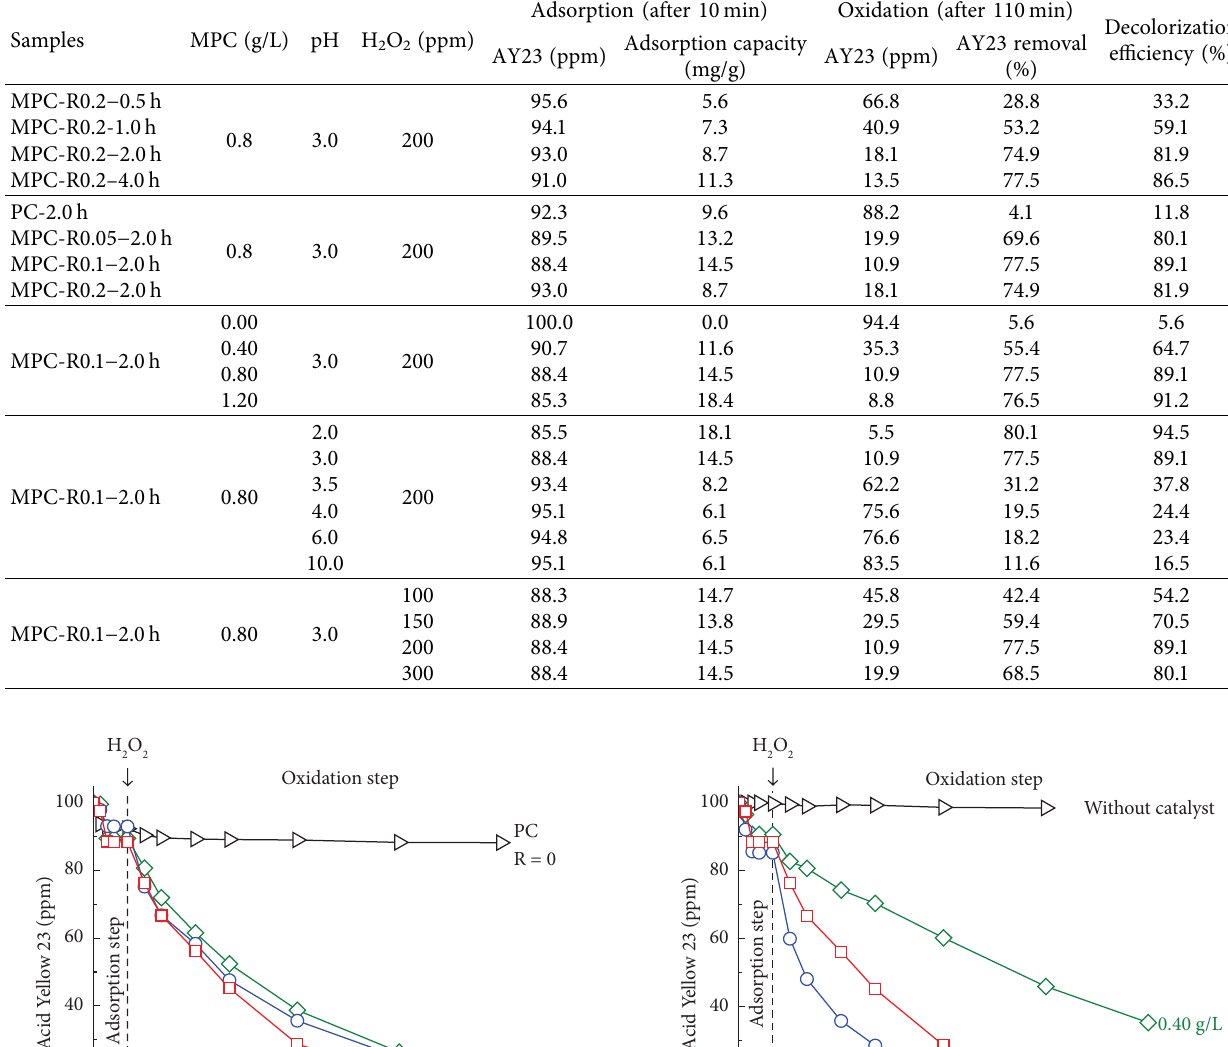
Table 3: Adsorption capacity and catalytic activity of PC and MPC samples on acid yellow 23.